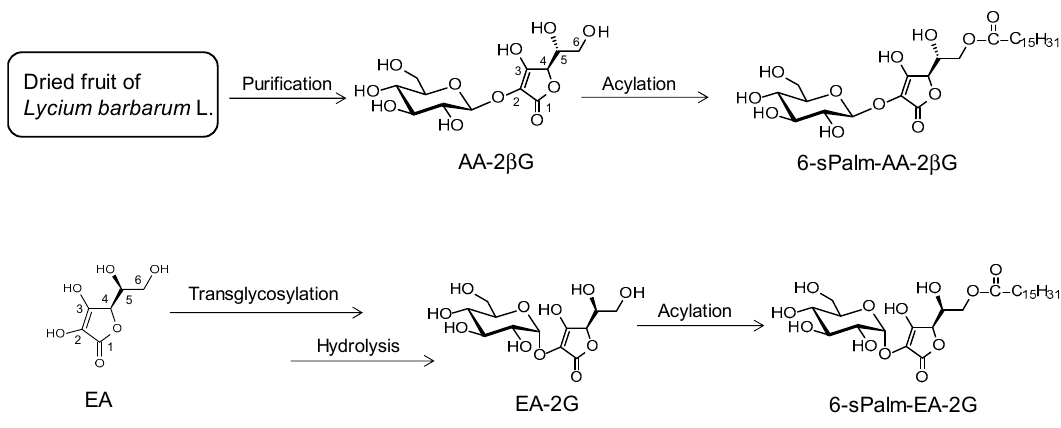
Figure 4. Structures and scheme for synthesis of 6-sPalm-AA-2 β G and 6-sPalm-EA-2G.